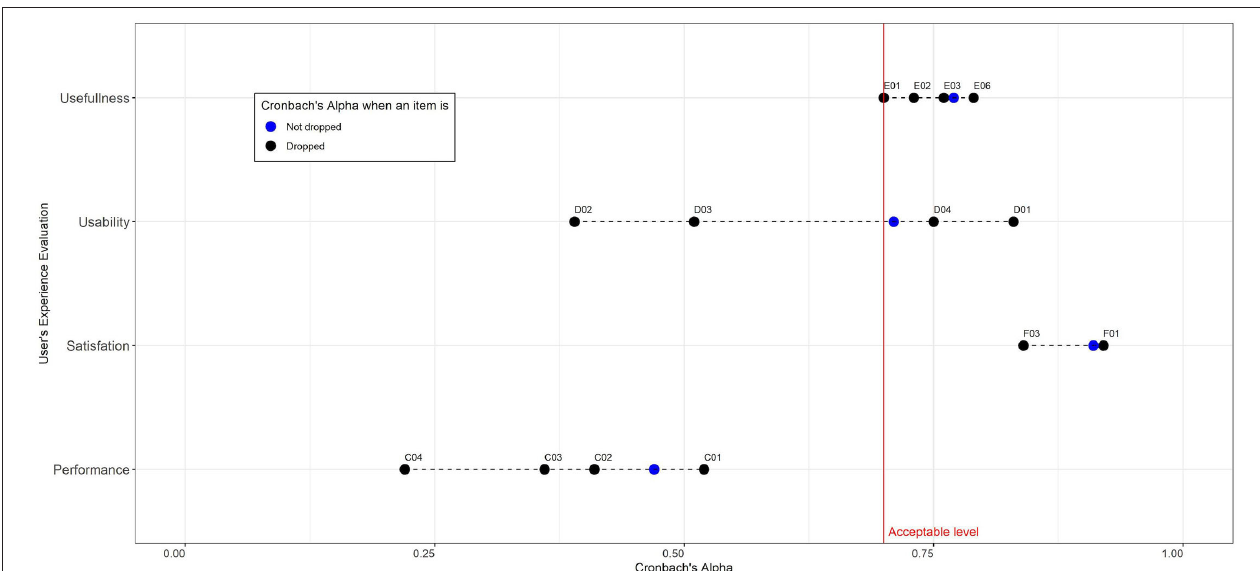
FIGURE 4 | Distribution of Cronbach’s α within the four constructs of user experience evaluation.